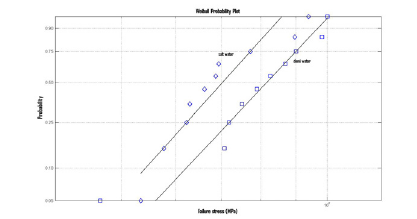
Figure 5: Weibull plot of slow tests in salt and demineralised water.